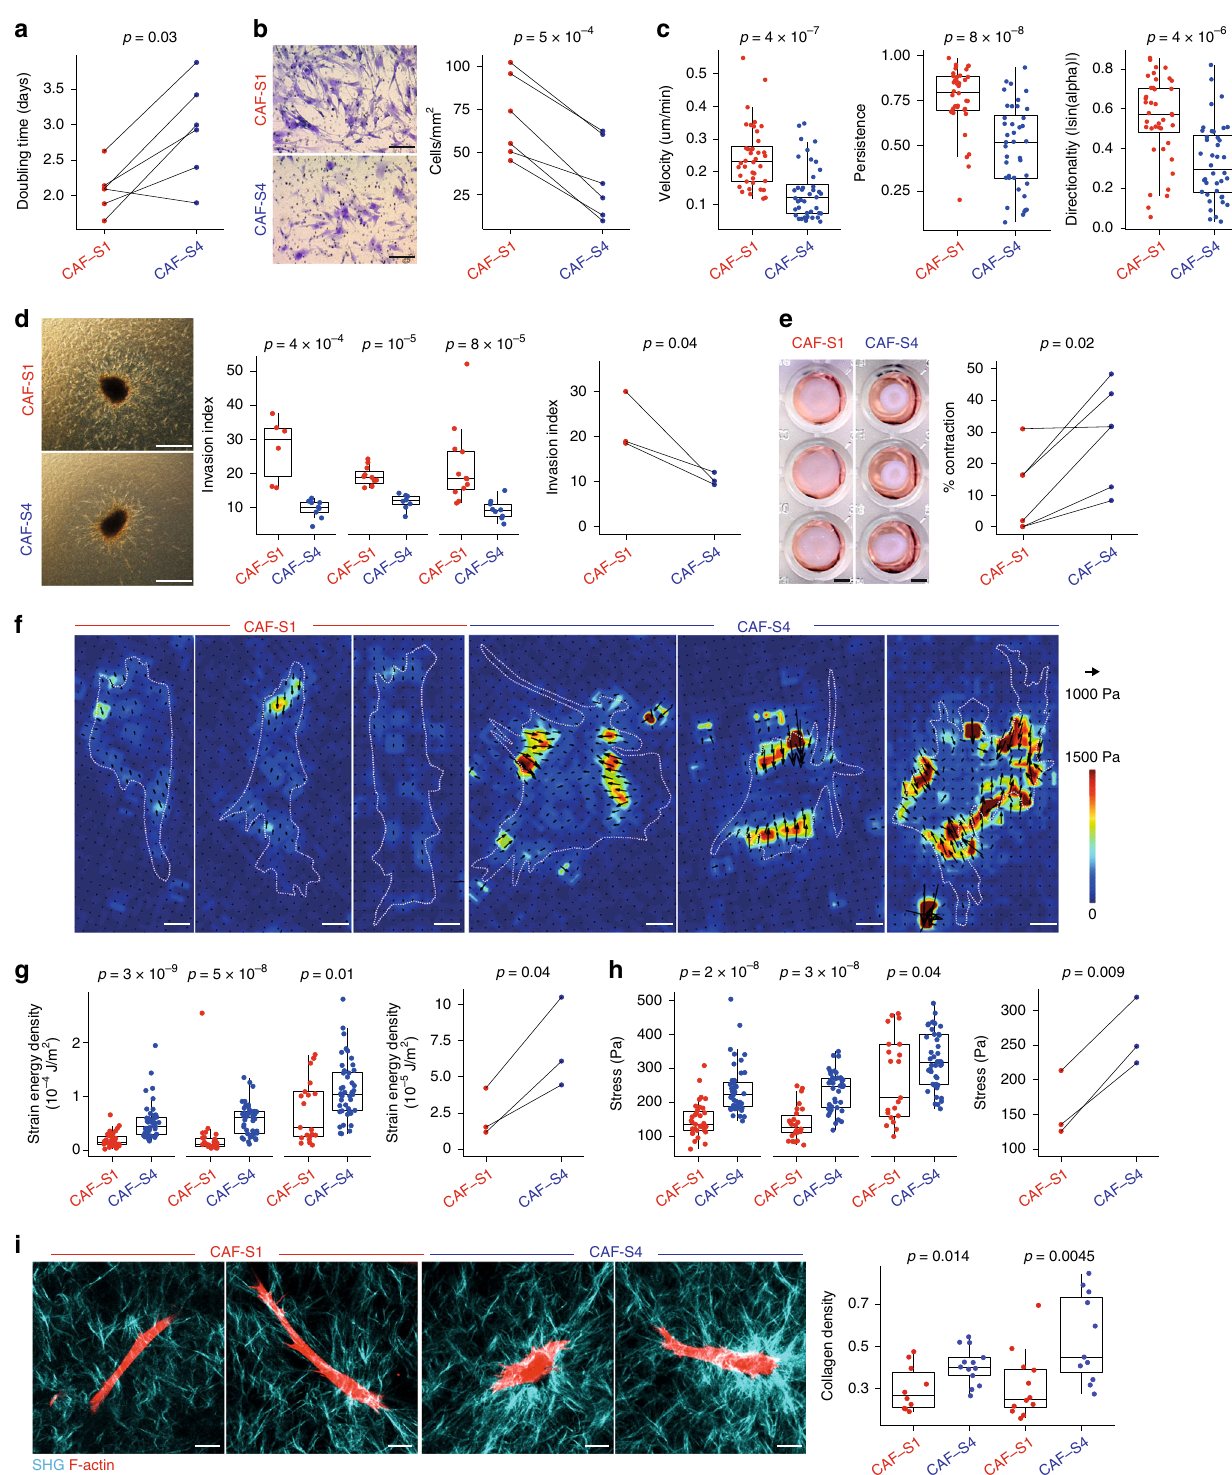
Fig. 3h), we compared the strain energy densities (strain energy normalized to the cell surface) and con fi rmed that CAF-S4 deployed more contractile energy per surface unit than CAF-S1 (Fig. 4g). Similar results were obtained using mean traction stress amplitude (mechanical forces cell develop per unit area to deform the substrate; arrows Fig. 4f, h). Collagen fi ber density was also increased around CAF-S4 compared to CAF-S1 cells (Fig. 4i), which is consistent with CAF-S4 capacity to exert higher traction